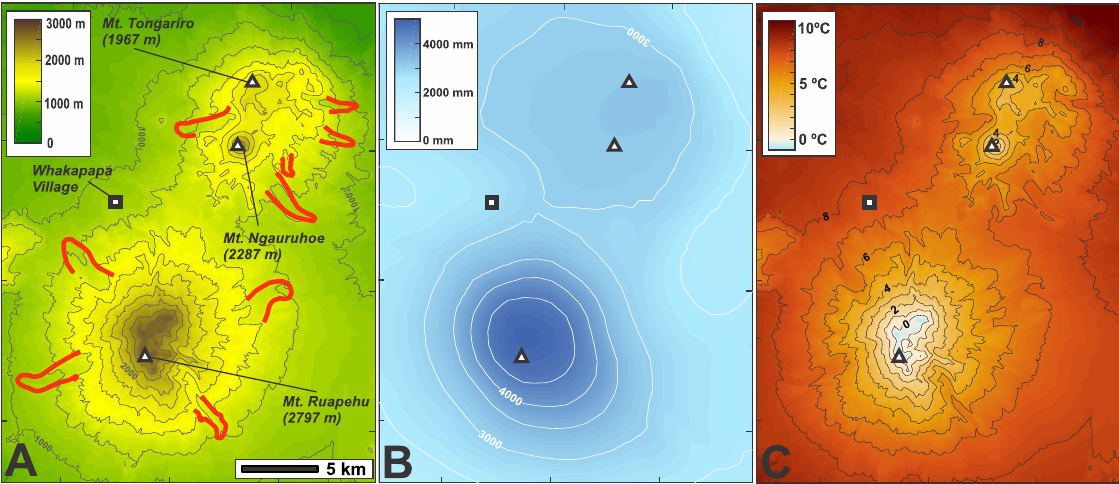
Figure 2. (a) Topography, with 200m contours and selected landmarks referred to in the text (Land Information New Zealand – LINZ). LGM glacial limits targeted in model simulations (from Fig. 1) are shown. (b) Mean annual precipitation surface (Tait et al., 2006). Precipitation isolines are shown in 500mm intervals. (c) Mean annual temperature derived using the methods outlined in the text with the lapse rates of Norton (1985). Isotherms are shown at intervals of 1 ◦ C. The symbols in panels (b) and (c) mark the landmarks labelled in panel (a) . Table 1. Glacial catchments targeted in our model experiments. Glacier Code Extant